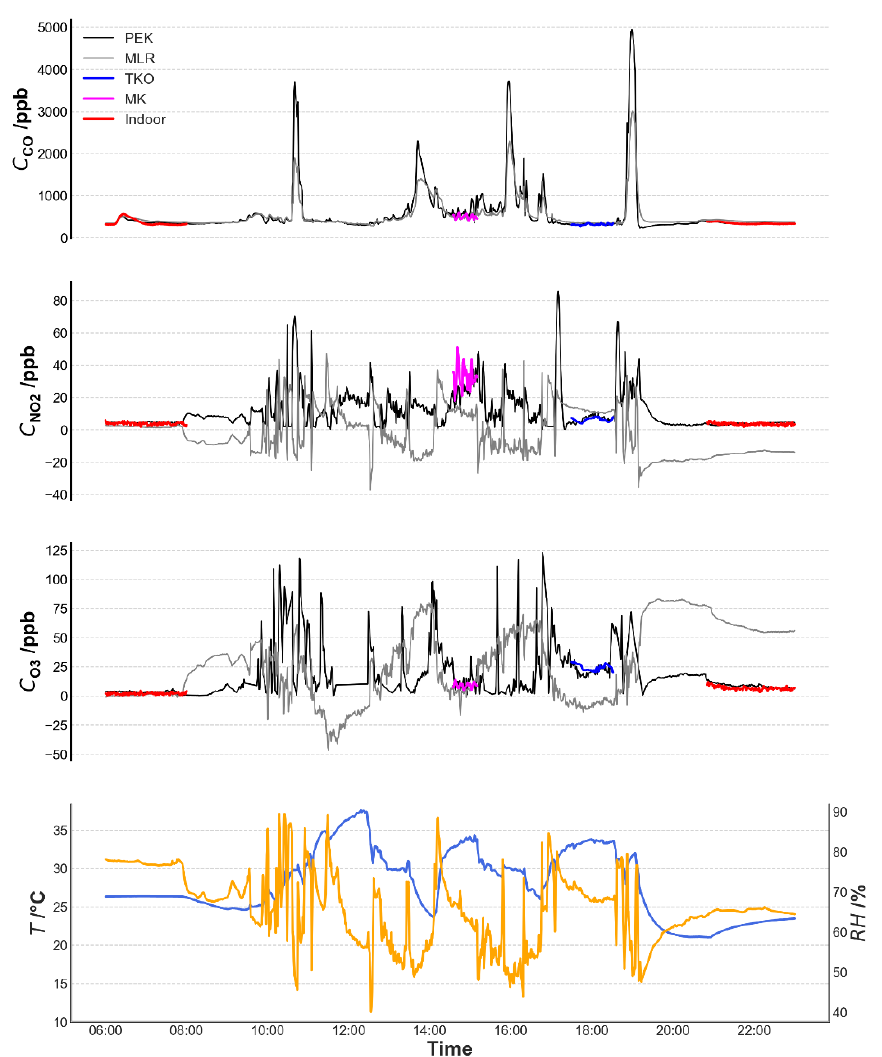
Figure 11. Temporal concentration variability of pollutants detected as Personal Exposure Kit (PEK) measurements and those tuned using the multi-linear regression model and ambient environmental factors as they vary simultaneously. Note: Data resolution is 1